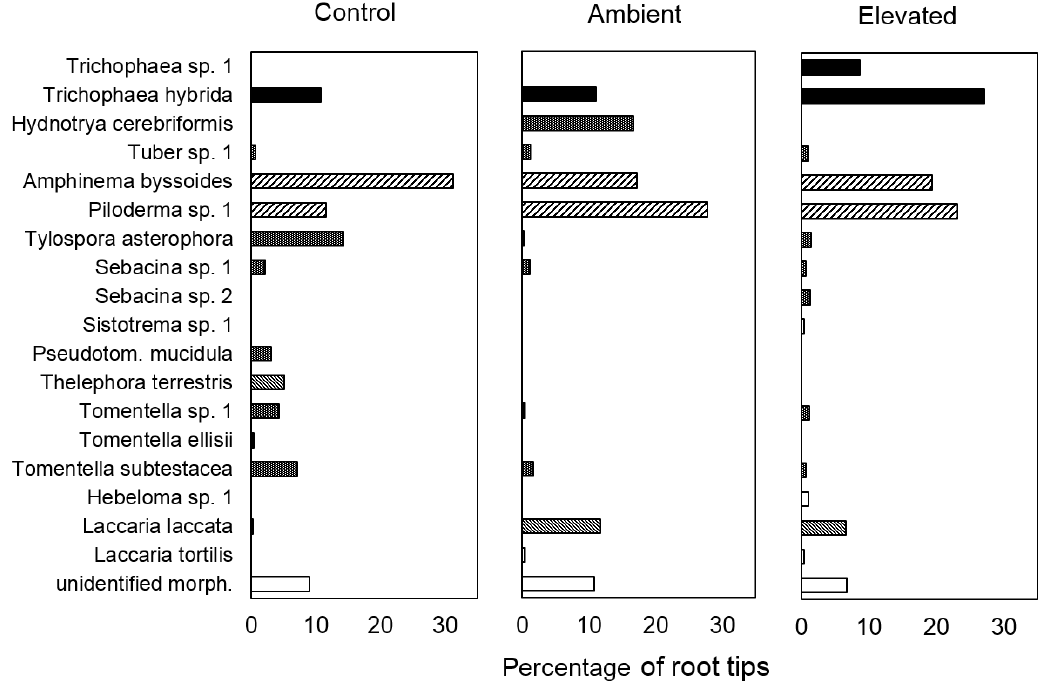
Figure 1. Ectomycorrhizal fungal species abundance as a percentage of total P. abies root tips colonised in glass domes in an unenclosed control, at ambient CO 2 or elevated CO 2 levels at the Bílý Kříž site. Exploration types: contact, short distance, medium distance smooth, medium distance